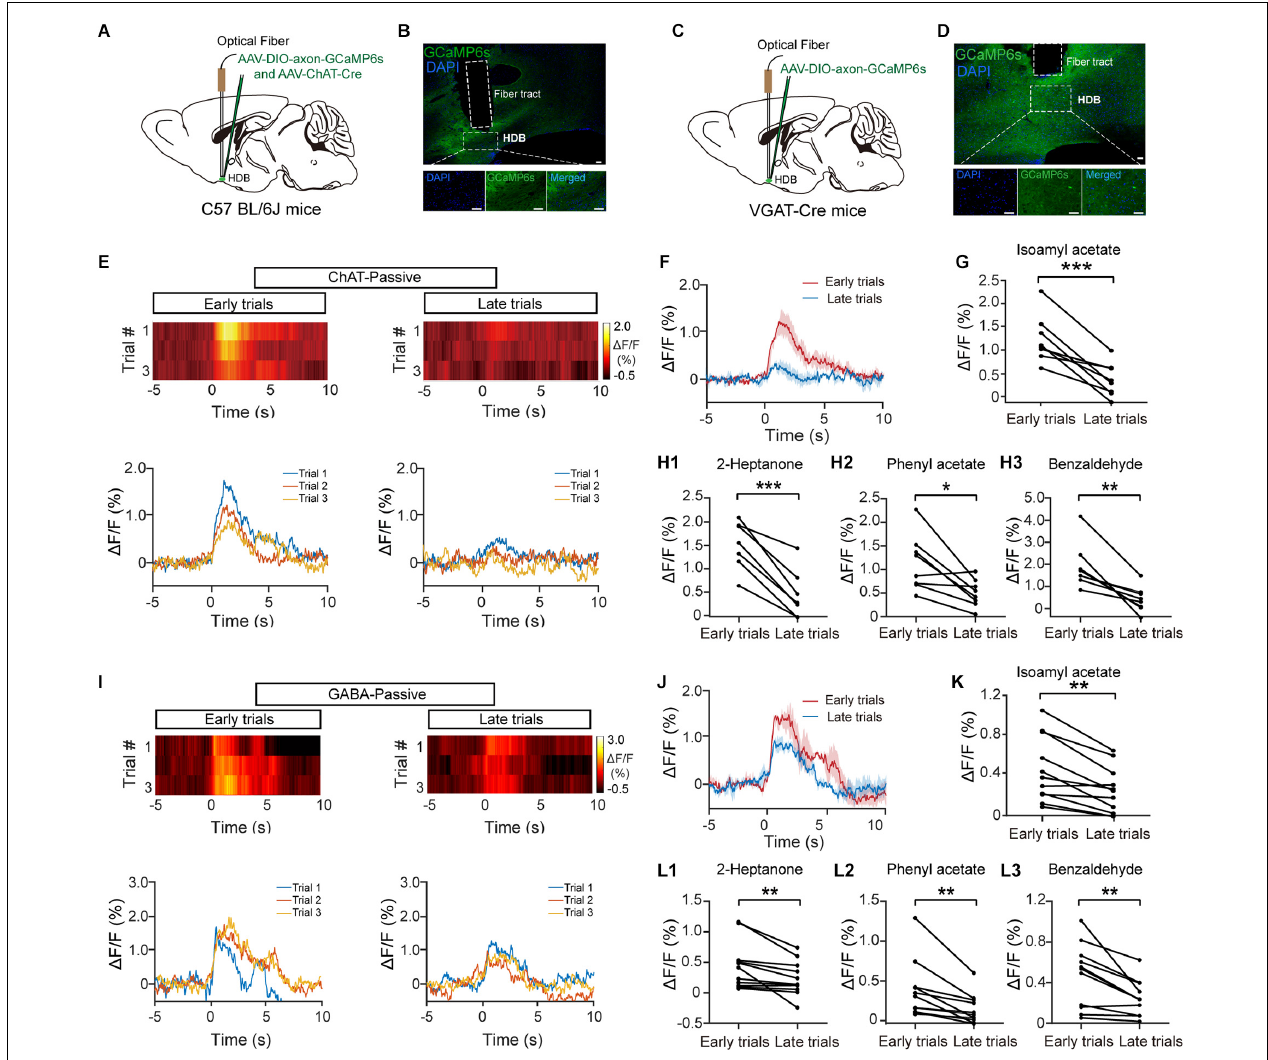
FIGURE 1 | The response profiles of HDB cholinergic and GABAergic neurons during passive exposure. (A) Diagram of virus injection. To record the calcium responses of HDB cholinergic neurons, AAV-ChAT-Cre and AAV-DIO-axon-GCaMP6s were injected into the HDB of C57BL/6J mice. (B) Sections showing expression of GCaMP6s in the HDB from a C57BL/6J mouse following virus injection. Scale bar: 50 µ m. (C) Diagram of virus injection. To record the calcium responses of HDB GABAergic neurons, AAV-DIO-axon-GCaMP6s were injected into the HDB of VGAT-Cre mice. (D) Sections showing expression of GCaMP6s in the HDB from a VGAT-Cre mouse following virus injection. Scale bar: 50 µ m. (E,I) Heat maps and traces of ∆ F/F for the first three trials (early trials) and the last three trials (late trials) in cholinergic neurons (E) or GABAergic neurons (I) from representative mice under repeated odor (Isoamyl acetate) exposure. (F,J) The trial-averaged traces of ∆ F/F in (E) and (I) , respectively. (G,K) The odor (Isoamyl acetate) responses in cholinergic (G) and GABAergic (K) neurons decreased in late trials compared with early trials [ (G) paired t -test, t (7) = 5.53, P = 8.9 × 10 − 4 ; (K) paired t -test, t (10) = 4.59, P = 0.001]. (H,L) The ∆ F/F in cholinergic (H) and GABAergic (L) neurons also decreased upon repeated exposure to other odors (2-Heptanone, Phenyl acetate, and Benzaldehyde, respectively) [ (H 1 ) paired t -test, t (7) = 8.37, P = 6.8 × 10 − 5 ; (H 2 ) paired t -test, t (7) = 3.37, P = 0.012; (H 3 ) paired t -test, t (7) = 4.68, P = 0.0023; (L 1 ) Wilcoxon signed-rank test, z = 2.85, P = 0.0044; (L 2 ) Wilcoxon signed-rank test, z = 2.93, P = 0.0033; (L 3 ) paired t -test, t (10) = 3.60, P = 0.0049]. * P < 0.05, ** P < 0.01, *** P <